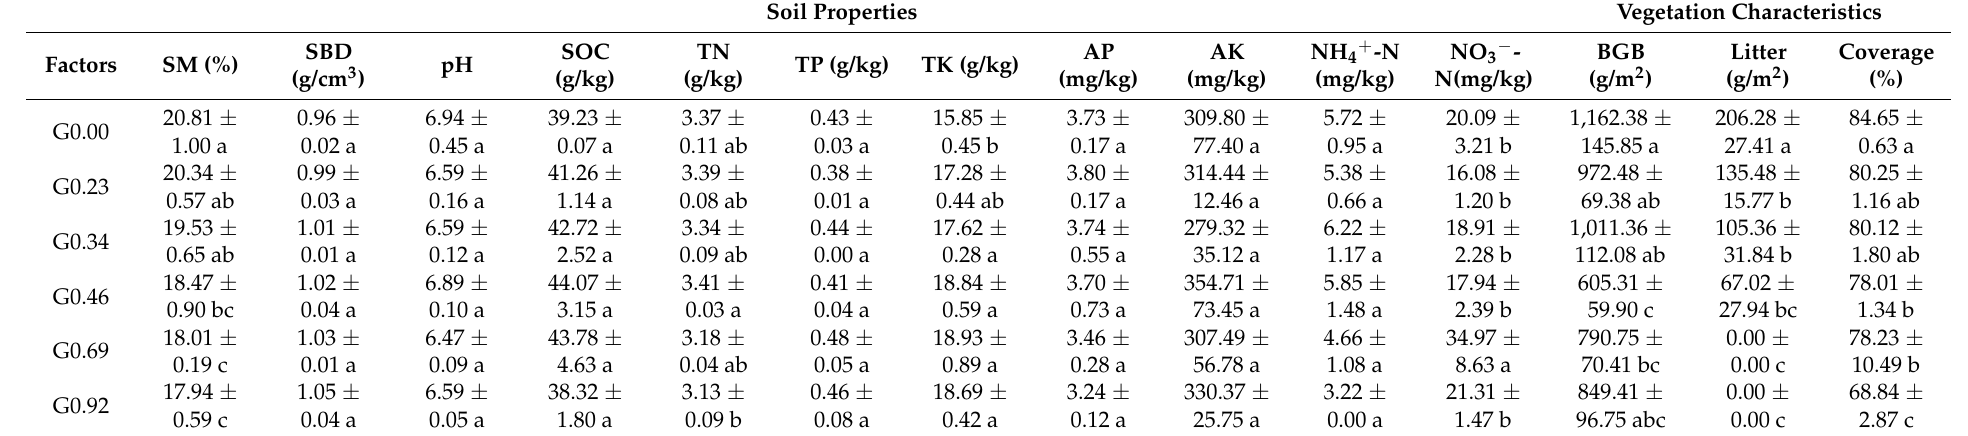
Table 1. Soil properties and vegetation characteristics (mean ± s.e.) under different grazing intensities after ten years of